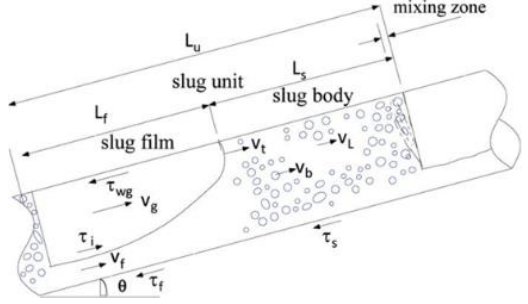
Figure 18. Slug flow unit schematic [31] .